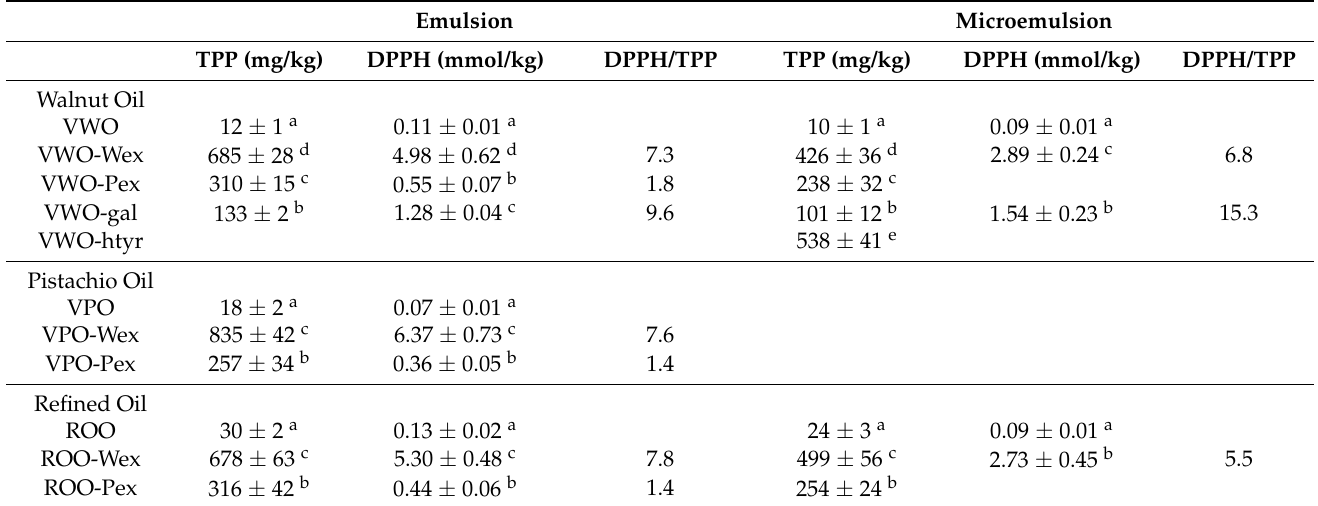
Table 2) as compared to pistachio extracts (Pex: 310, 257 and 316 mg/kg, respectively). This is mainly due to the different phenolic content in the two nut type extracts used. Table 2. Phenolic content and DPPH antioxidant capacity of studied of oil formulations in emulsion and microemulsion ( n =